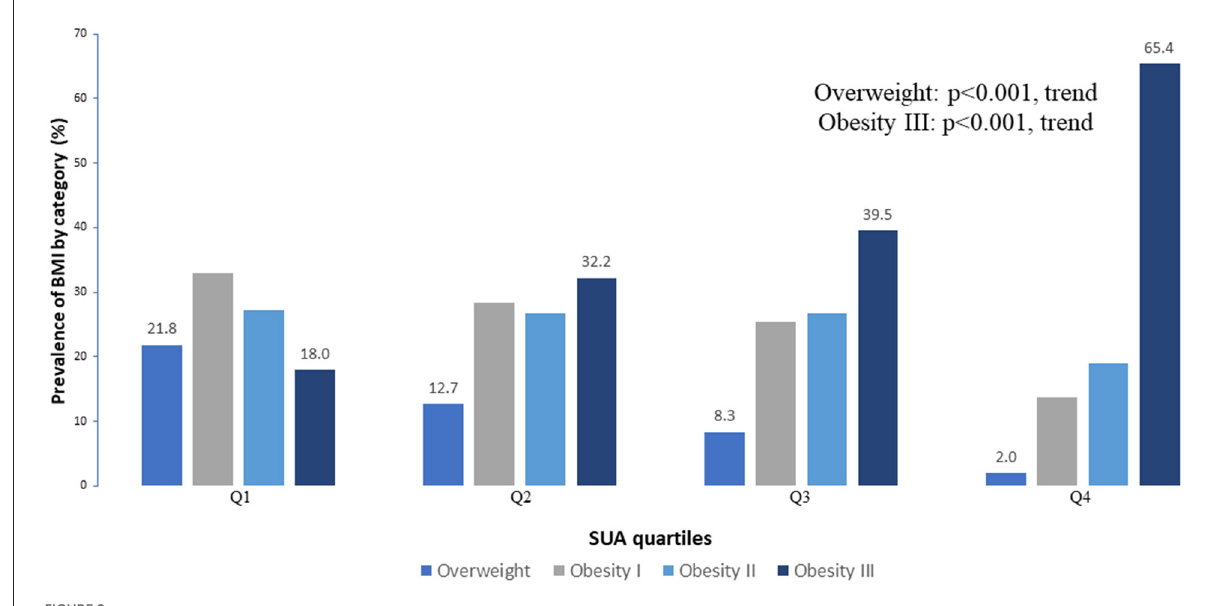
FIGURE2 Comparison of obesity category between the SUA quartile